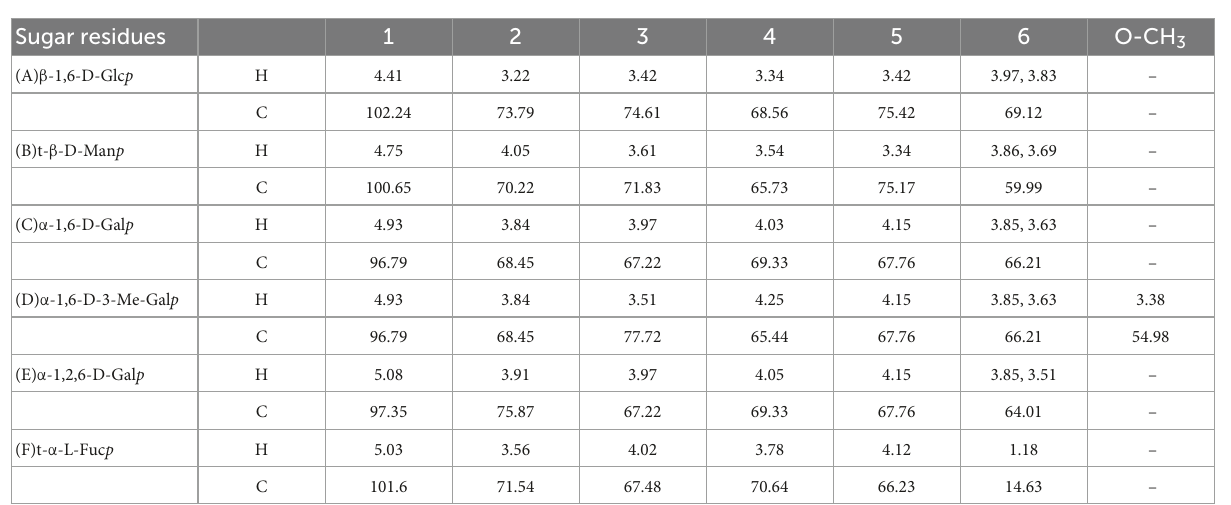
TABLE 3 1H and 13C NMR spectra assignments for SRF-3